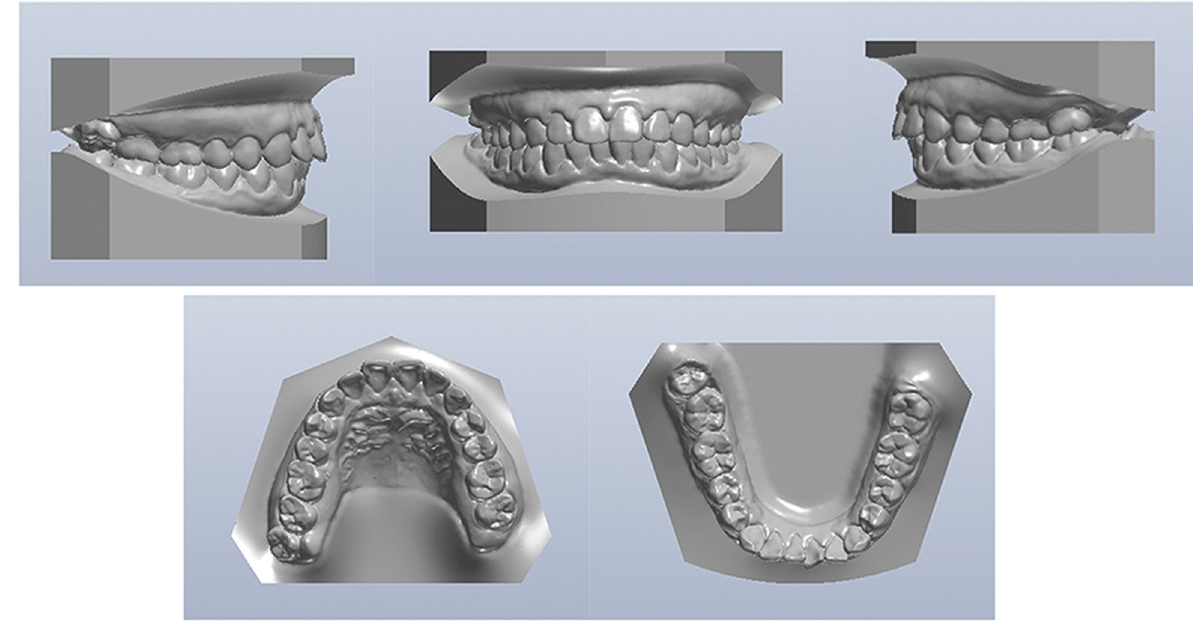
Figure 2. Pretreatment dental